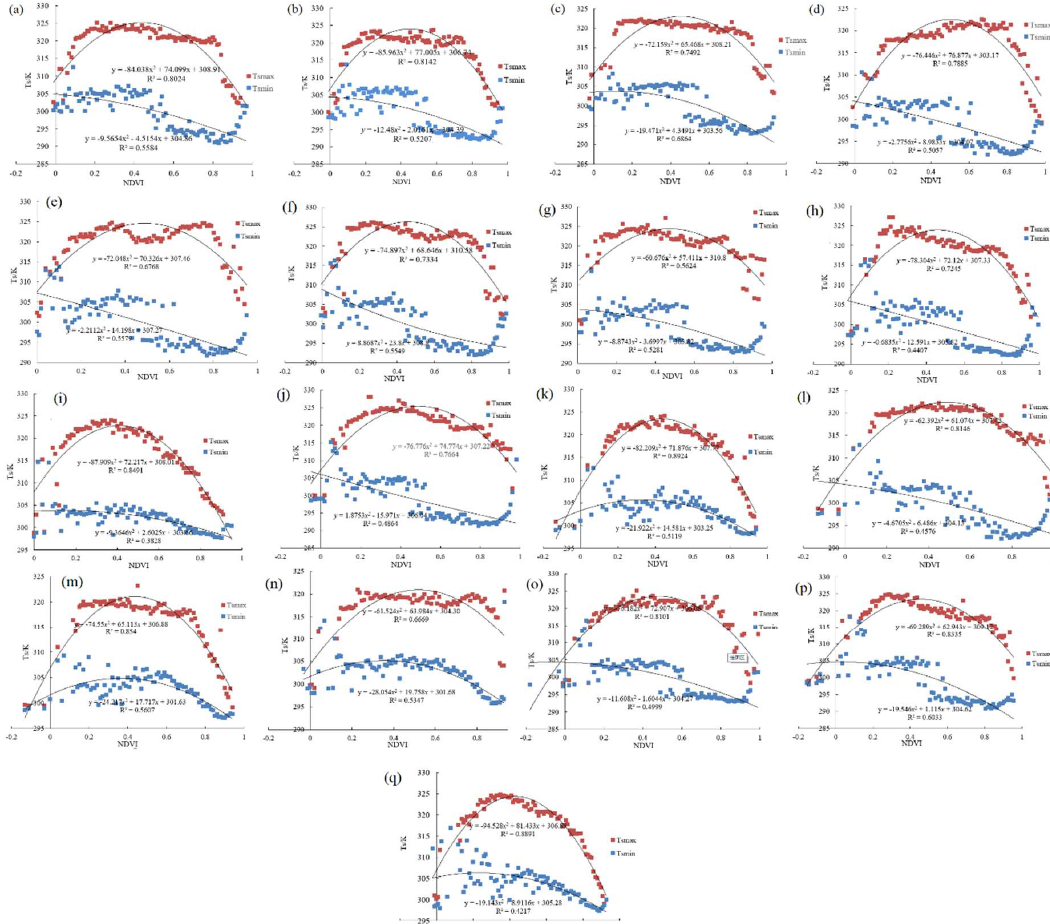
Figure 4. Scatter plots of dry and wet edges in NDVI-T s space between 2000 to 2016. ( a ) 2000, ( b